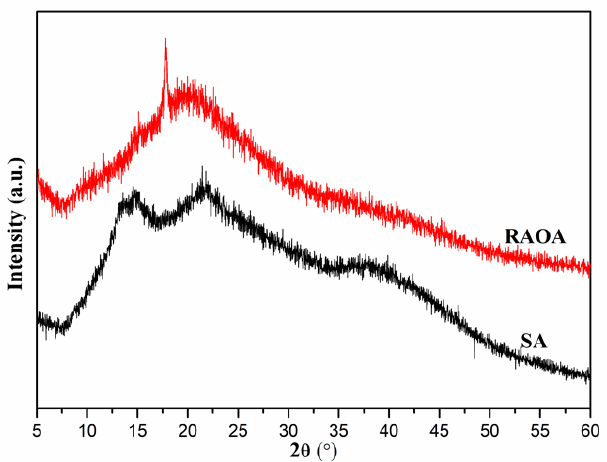
Figure 3. X ‐ ray diffractograms of SA and RAOA. Figure 3. X-ray diffractograms of SA and